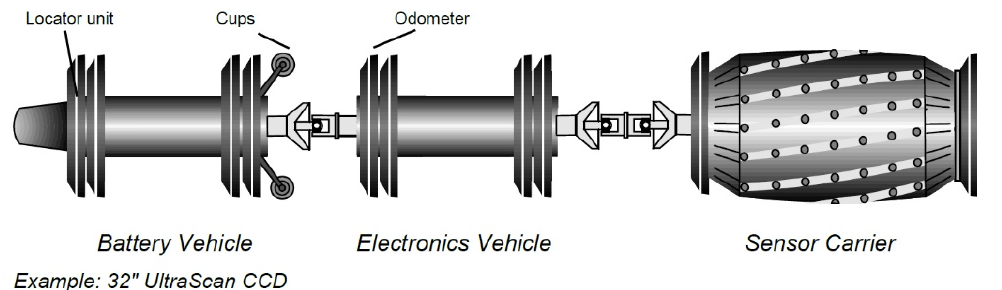
Figure 1. UltraScan™ CCD Inspection Tool. Figure 1. UltraScan ™ CCD Inspection